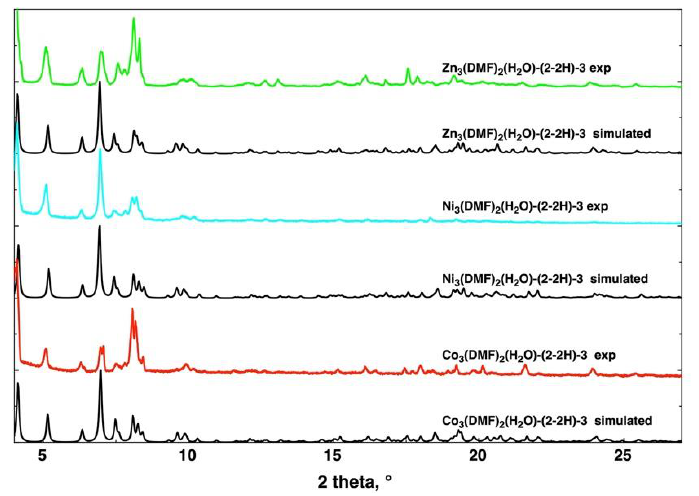
Figure 5. For M 3 (H 2 O)(DMF) 2 -( 2- 2H) -3 (M = Co II (red), Ni II (light blue) and Zn II (green)), comparison of the simulated and experimental powder X-Ray di ff raction studies (PXRD) diagrams. M 3 (DMF) 2 (H 2 O)-(2-2H)-3 (M = Co II , Ni II and Zn II ) metallamacrocycles were obtained as